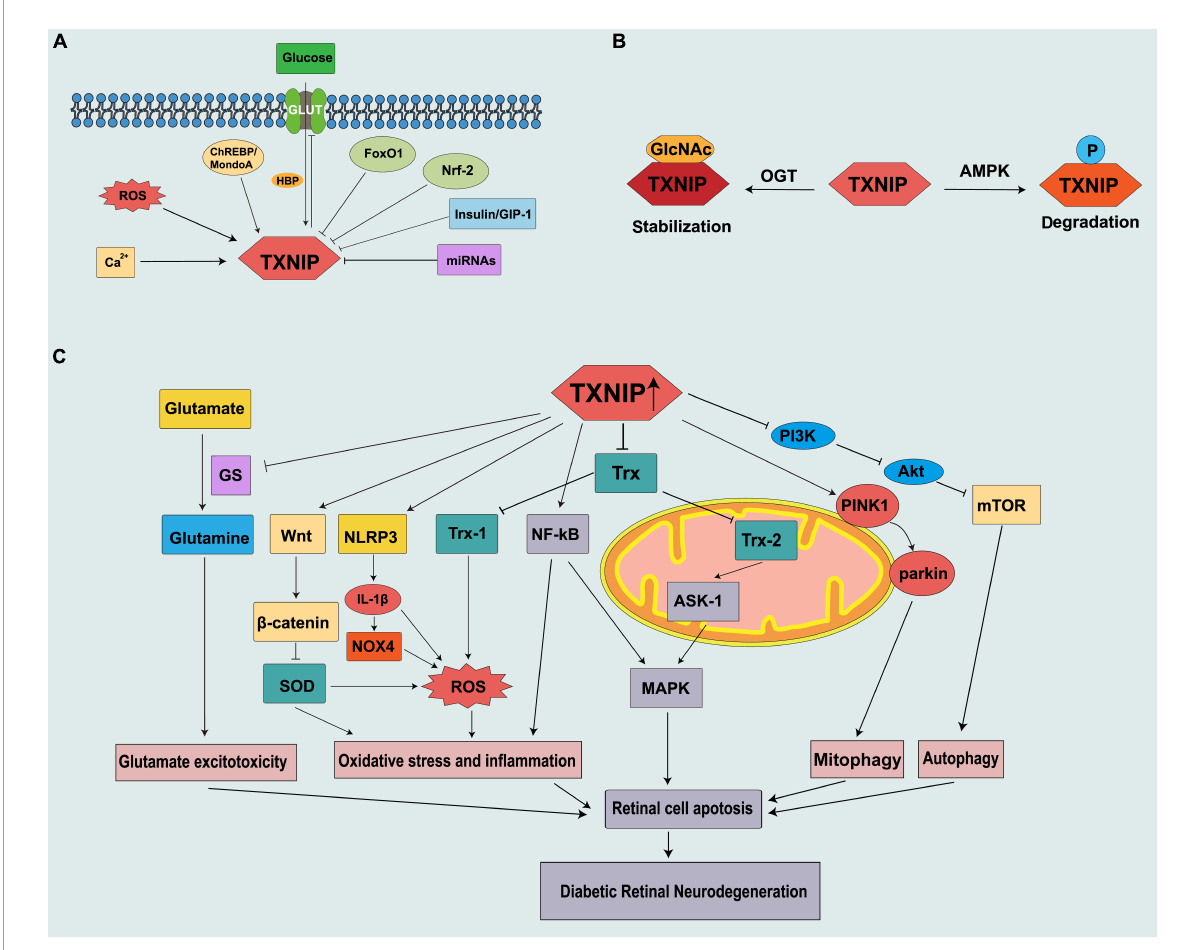
FIGURE1 Schematic representation of thioredoxin-interacting protein (TXNIP) being regulated in diabetes and contributing to the pathogenesis of DRN. (A) Mechanism of TXNIP regulation at the translational level. (B) Mechanism of TXNIP regulation at the post-translational level. (C) TXNIP participates in different signaling pathways to promote